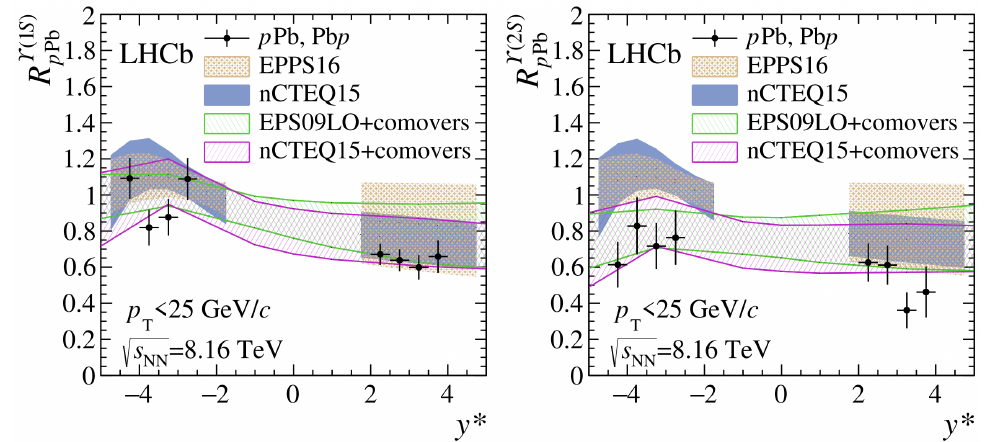
Figure 21. The Υ (1S) ( left ) and Υ (2S) ( right ) nuclear modification are shown as a function of rapidity in p + Pb collisions [93]. The data are compared with different theoretical models described in the text. Reprinted with permission from Springer